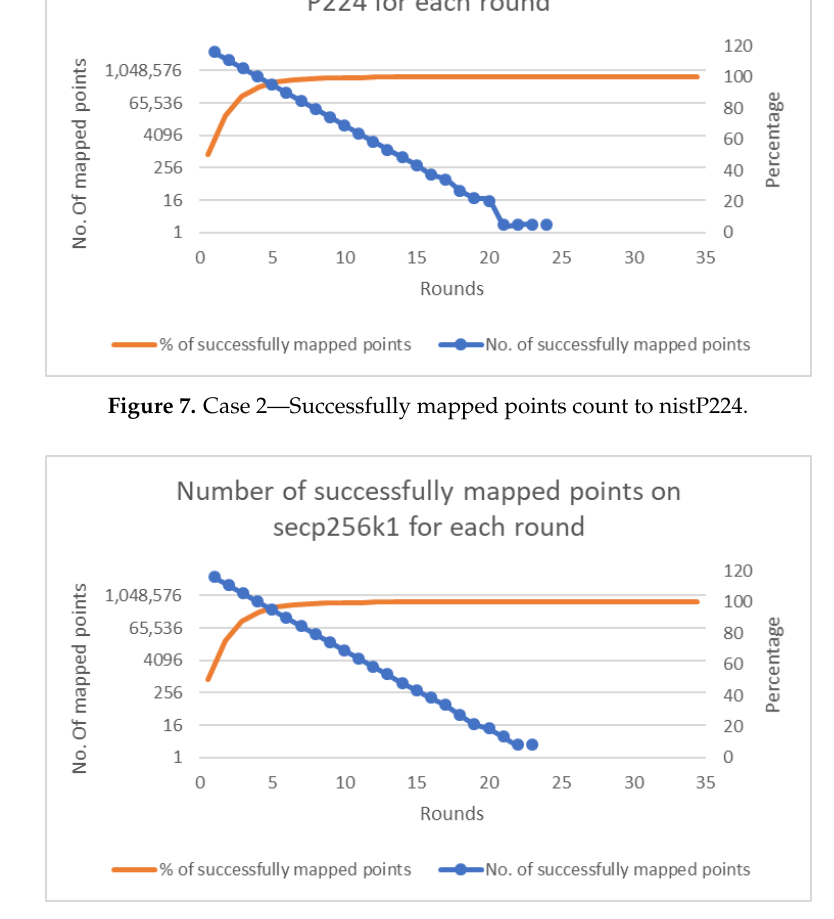
Figure 8. Case 3—Successfully mapped points count to secp256k1.